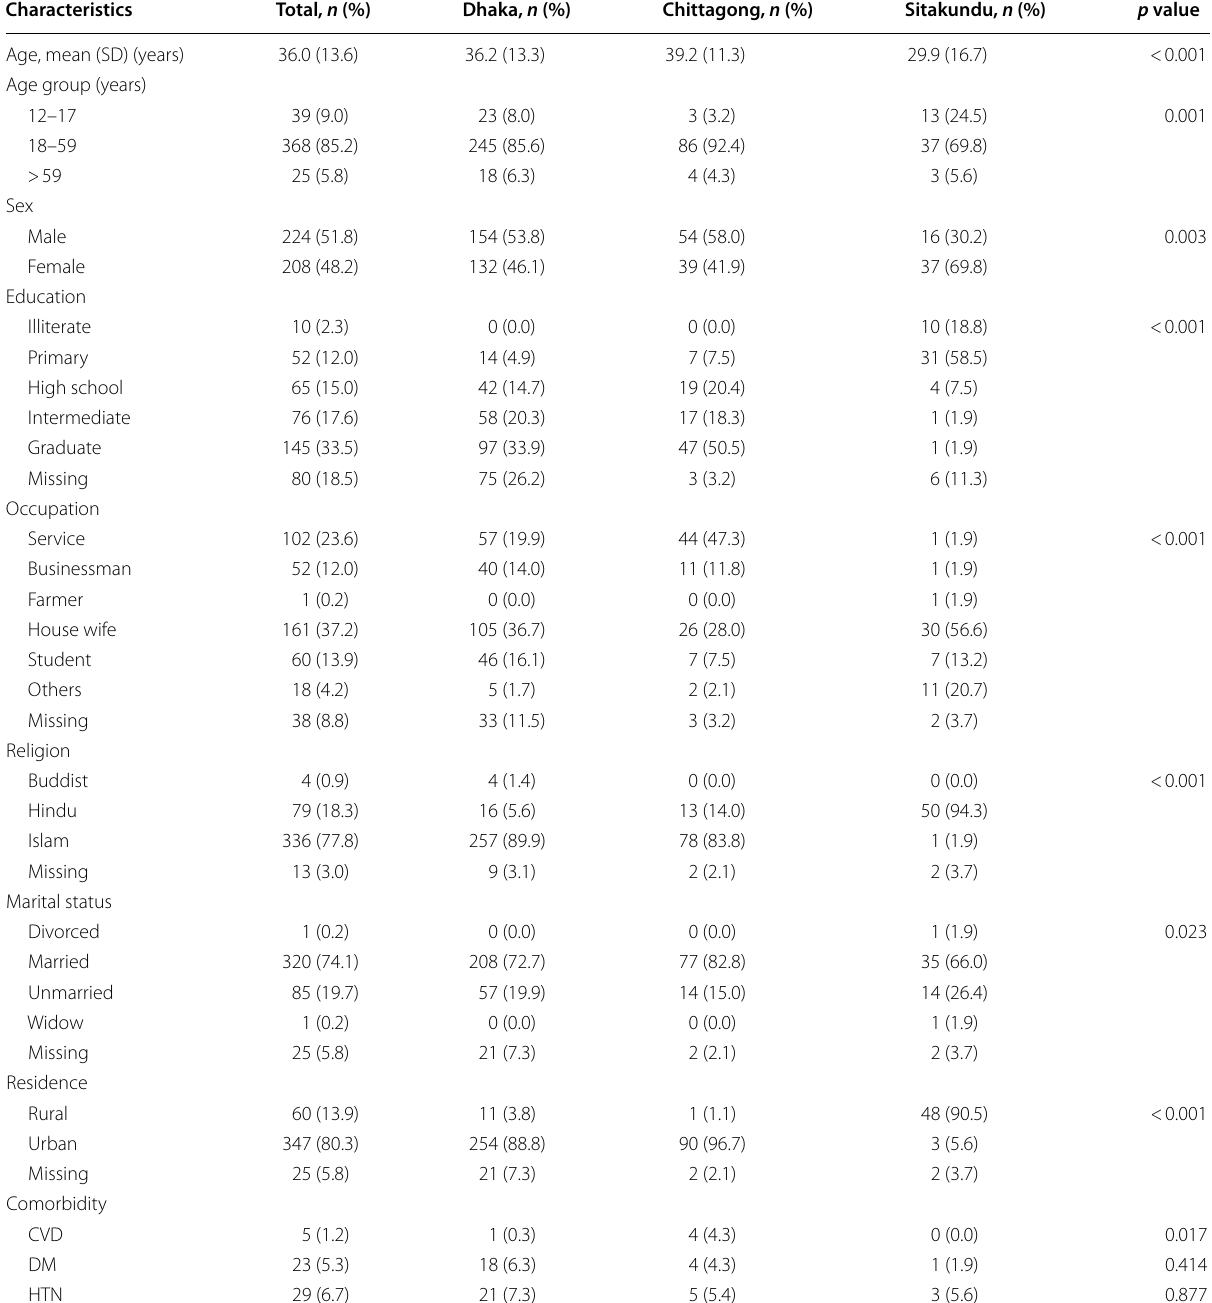
Table 1 Socio-demographic characteristics of the chikungunya patients from different hotspots ( n